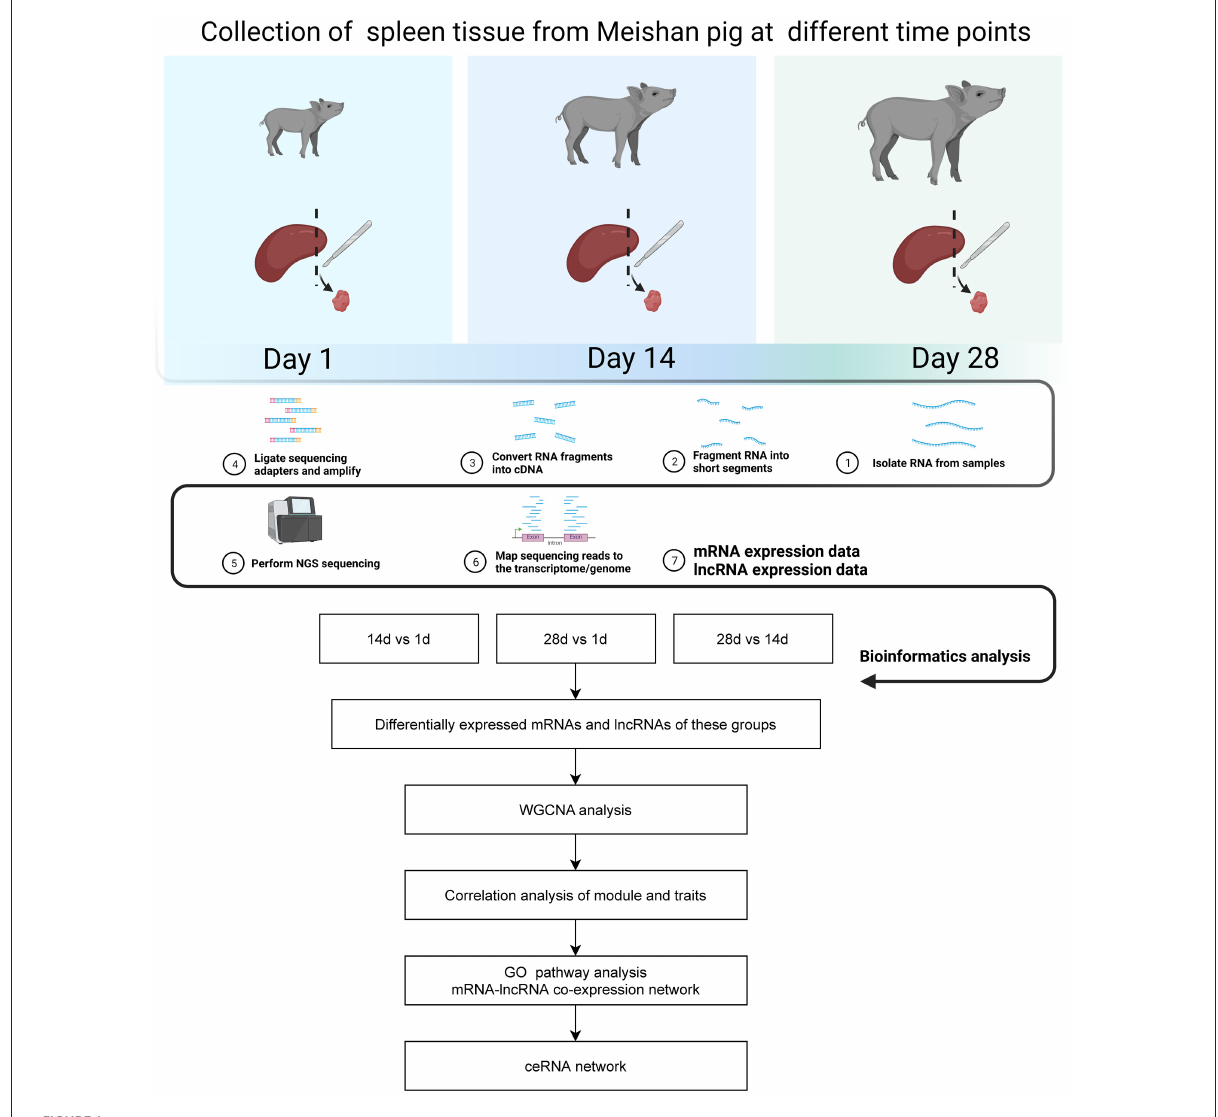
FIGURE1 Flow chart of data